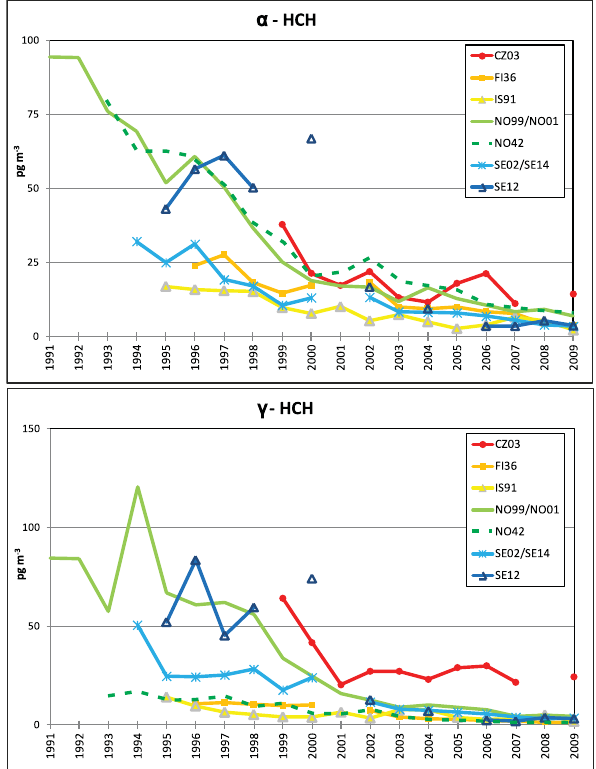
Fig. 23. Temporal trends in annual average air concentrations (pgm − 3 ) for α -HCH (top) and γ -HCH (bottom) at EMEP sites. Two sites located in the vicinity of each other both in Norway and Sweden are combined for trend